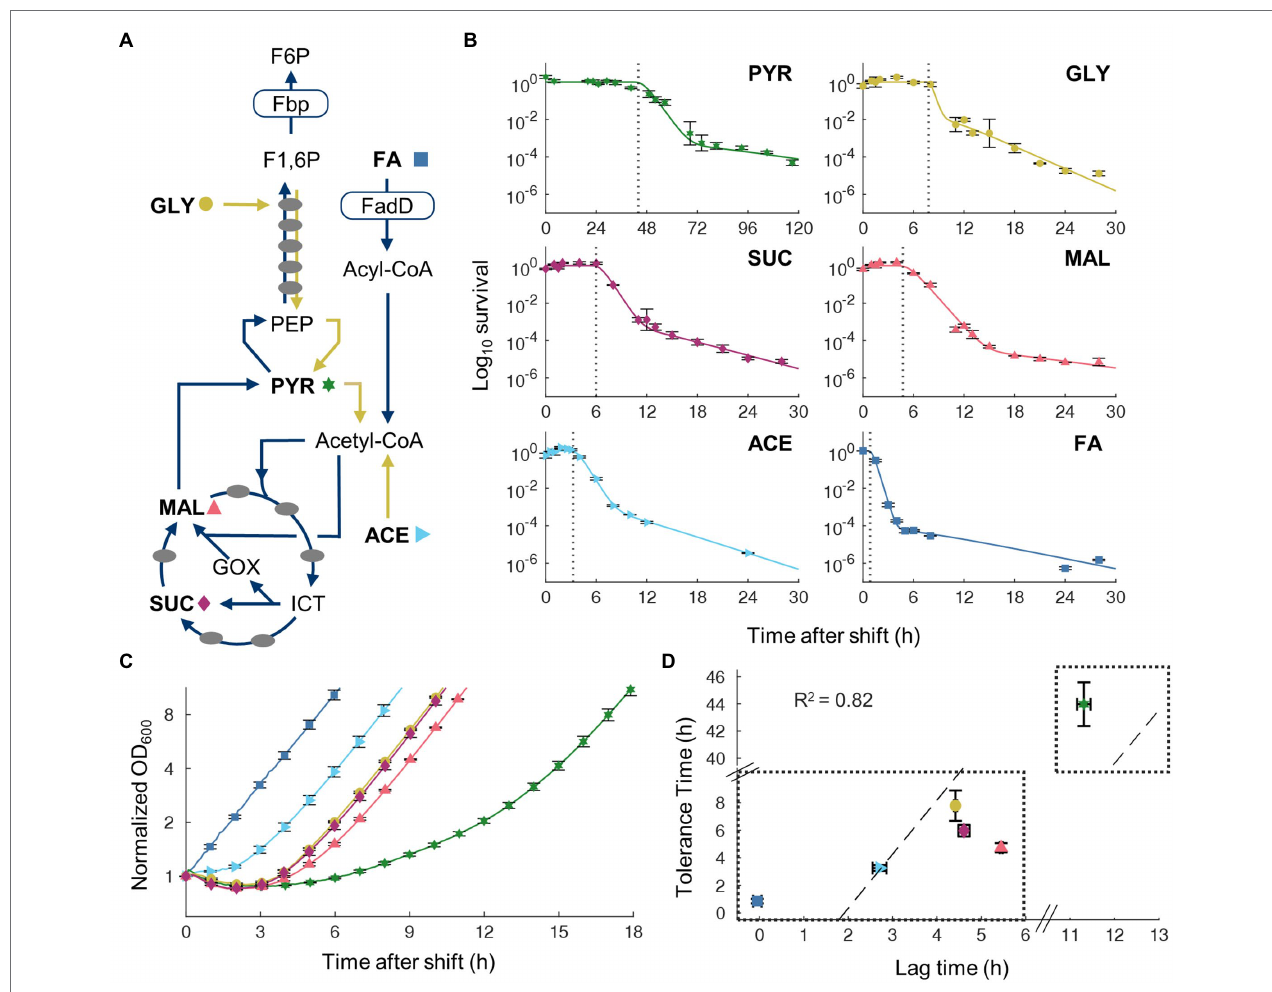
FIGURE 2 | Tolerance time correlates with lag time on transitions from gluconeogenic carbon sources to oleate. (A) Simplified metabolic network for gluconeogenic carbon source utilization. Pre-shift carbon sources used are in bold with a corresponding symbol indicating that carbon source: (FA, square; acetate, right-pointing triangle; pyruvate, star; glycerol, circle; malate, up-pointing triangle; and succinate, kite). Dark arrows indicate pathways necessary for FA utilization. Names of key metabolite intermediates and enzymes are shown. (B) Time course survival curves of cells after shifts from gluconeogenic carbon sources to FA with 100 μ g/ml ampicillin. Data points are averaged values from biological replicates, n = 3. Curves are fitting of a two-population Gompertz model to experimental data. Vertical dashed line indicates tolerance time determined by fitting the Gompetz model. (C) Time course OD 600 after shift from gluconeogenic carbon to FA without ampicillin, normalized to time point t = 0. Average of biological replicates, n = 3, SEM error bars. (D) Correlation between measured tolerance time and lag time after switch to FA. Dashed line is least-squares linear fit to the data with equal